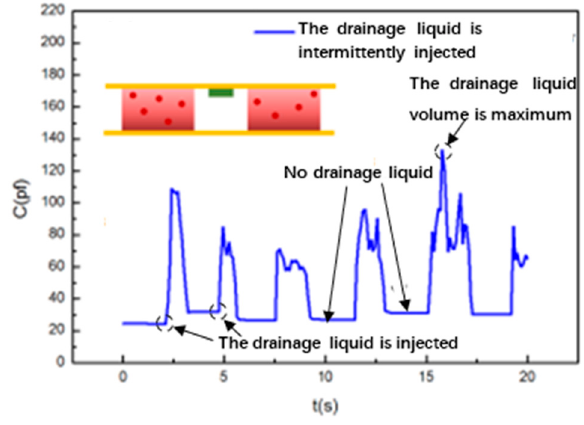
Figure 7. Capacitance change curve diagram of the sensor monitoring the drainage tube’s working state when the entire pipeline is unobstructed and liquid and air are intermittently